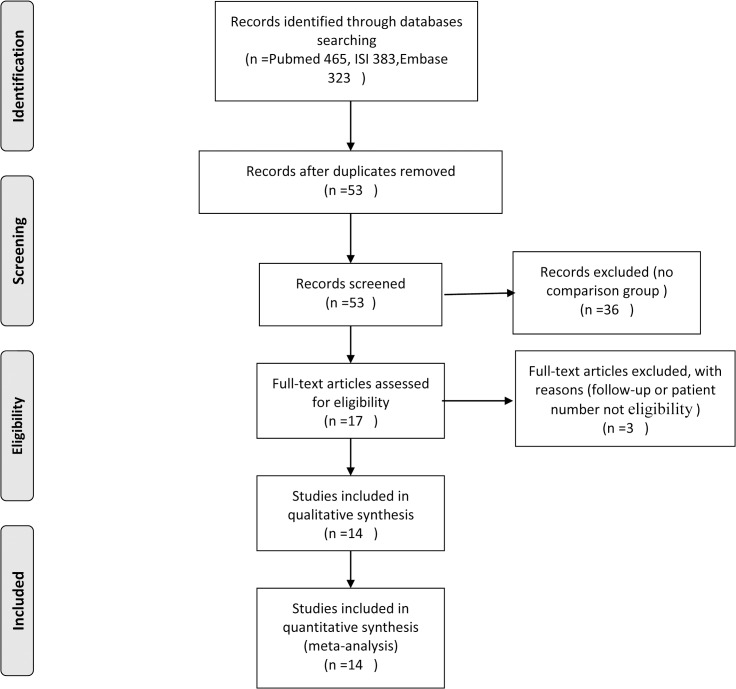
A flow diagram of the search process.